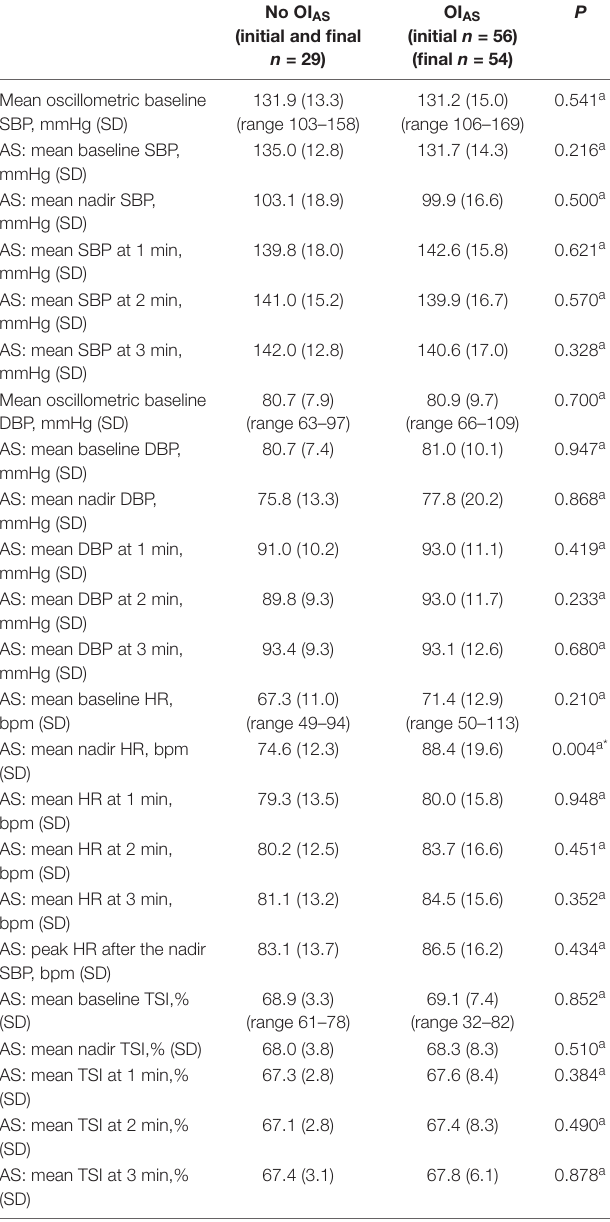
TABLE 2 | | Haemodynamic comparison between OI AS and non-OI AS subgroups.